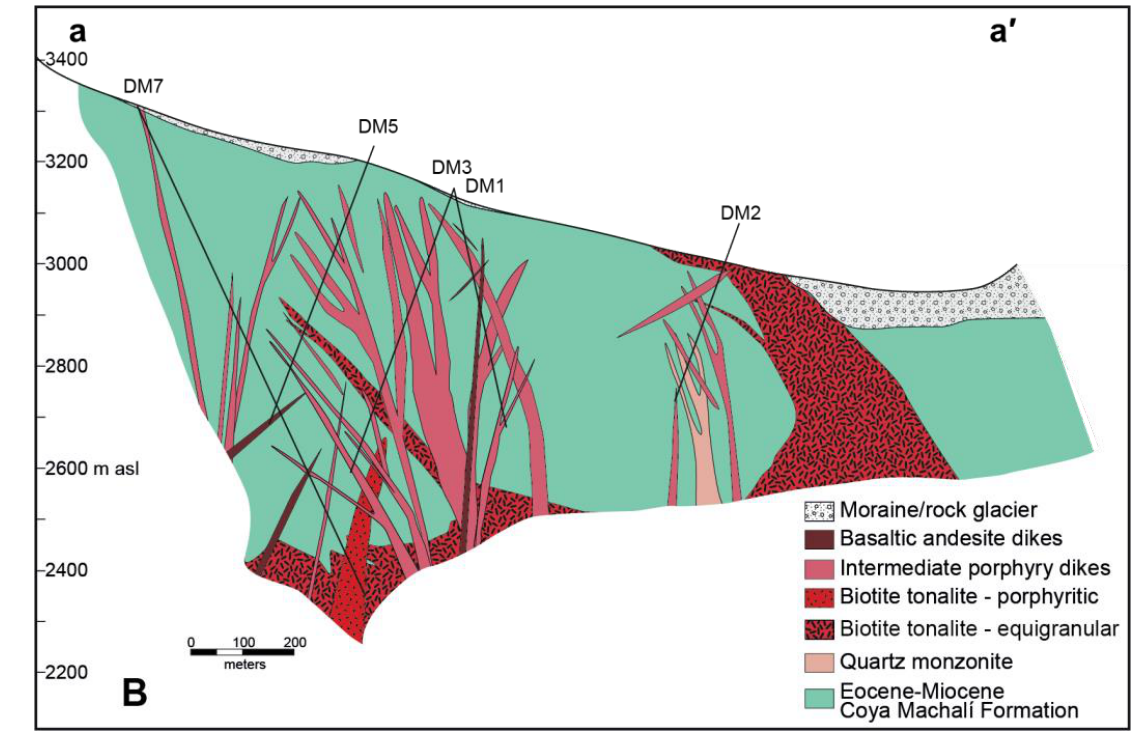
Figure 2. ( A ) Geologic map of the Don Manuel area showing the location of the Paredones and Don Manuel Principal sections of the study area and drill hole locations. Mineralization is confined to the Don Manuel Principal area. Modified after Candia et al. (2009). ( B ) Schematic cross section through the mineralized area at Don Manuel Principal. Crosscutting relationships are shown based on logging by the lead author, supplemented by logs of surface samples and drill cores from BHP.